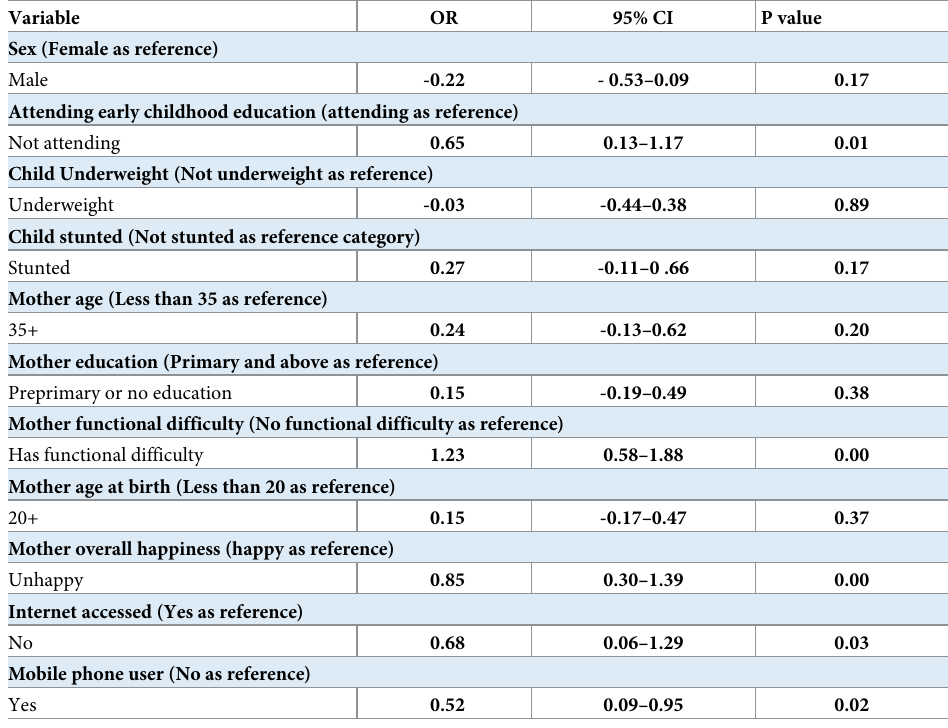
Table 2. Ordinal logistic regression model for factors associated early childhood